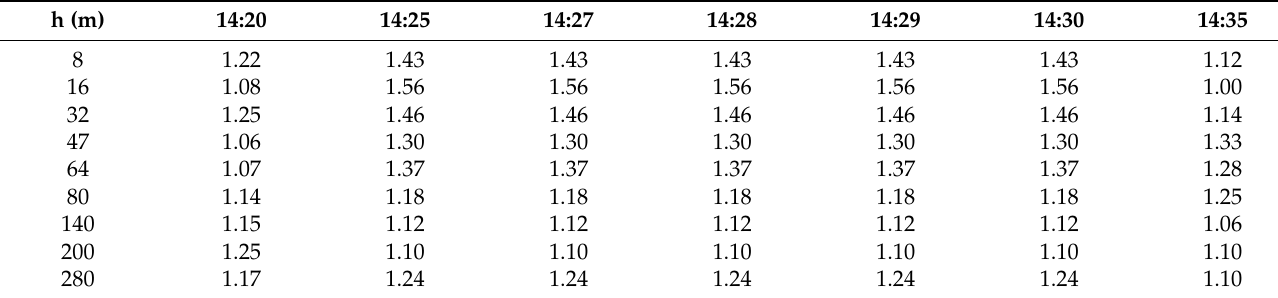
Table 3. Gust factors at some significant